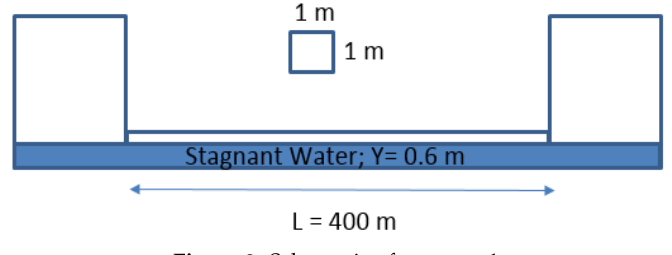
Figure 2. Schematic of test case 1.